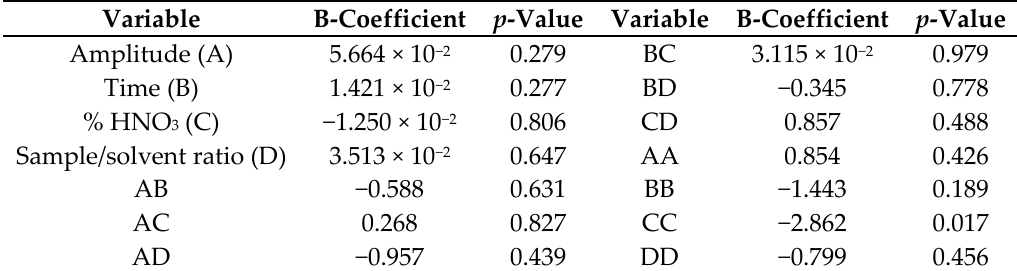
Table 1. Regression coefficients (B-coefficients) and p -values obtained with the US probe extraction method. Surface response were based on recovery rates for